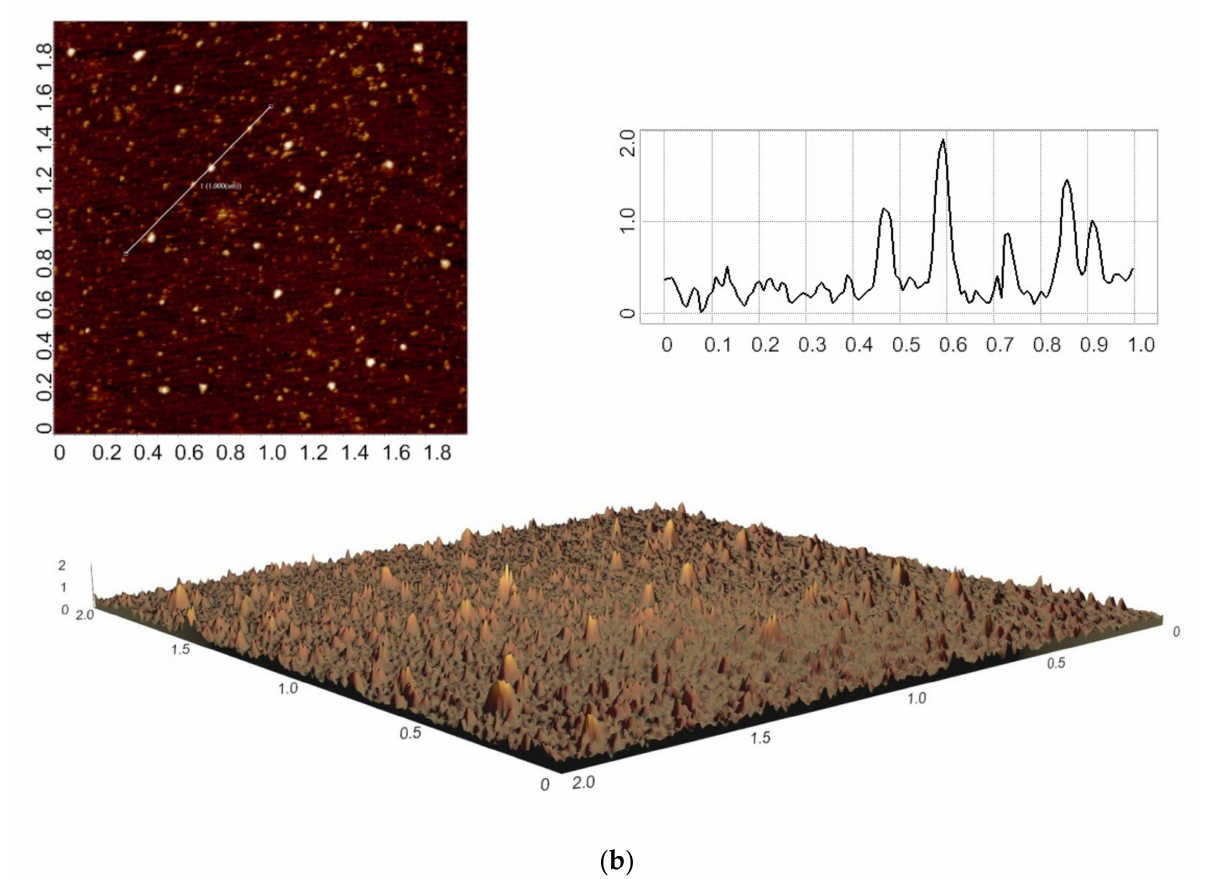
Figure 2. Typical 2D (top left) and 3D (bottom) AFM images (scan size 2 × 2 µ m, Z scale 2 nm) and corresponding cross-section profiles (top right; X scale 1 µ m; Y scale 2 nm) of mica substrates incubated in HRP solutions, which exposed near the top of the cone with the AC power supply turned on ( a ) and off (( b ), control experiment). Experimental conditions: the solution contained 10 − 7 M HRP in 2 mM Dulbecco’s modified phosphate buffered saline (pH 7.4); 10 kV, 50 Hz sinusoidal voltage was applied from the power supply ( a